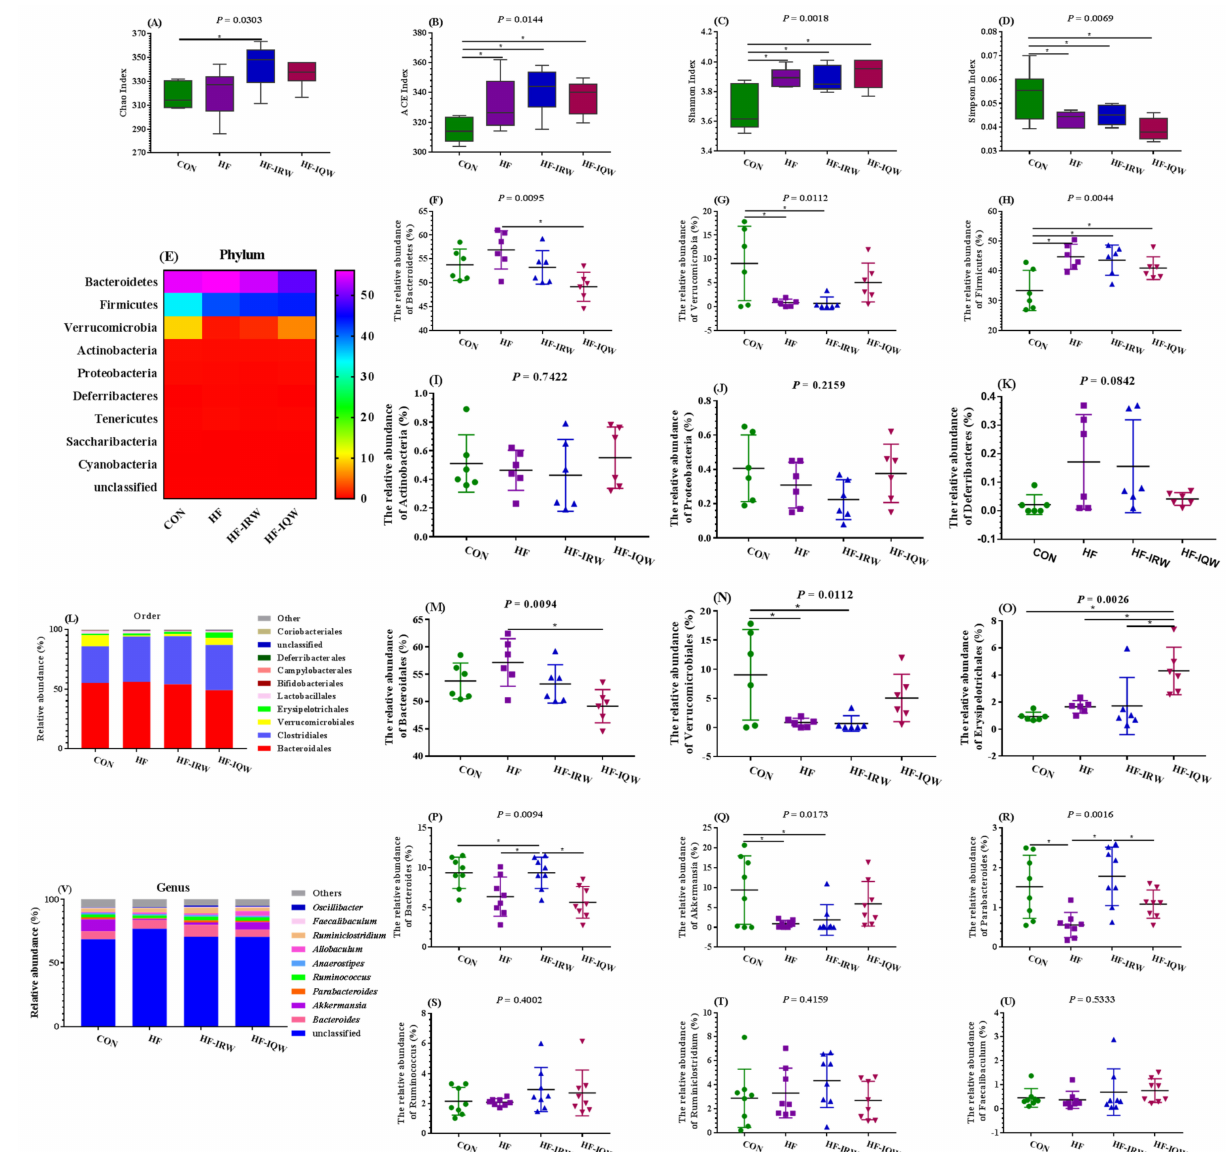
Figure 5. Effects of egg protein transferrin-derived peptides IRW (lle-Arg-Trp) and IQW